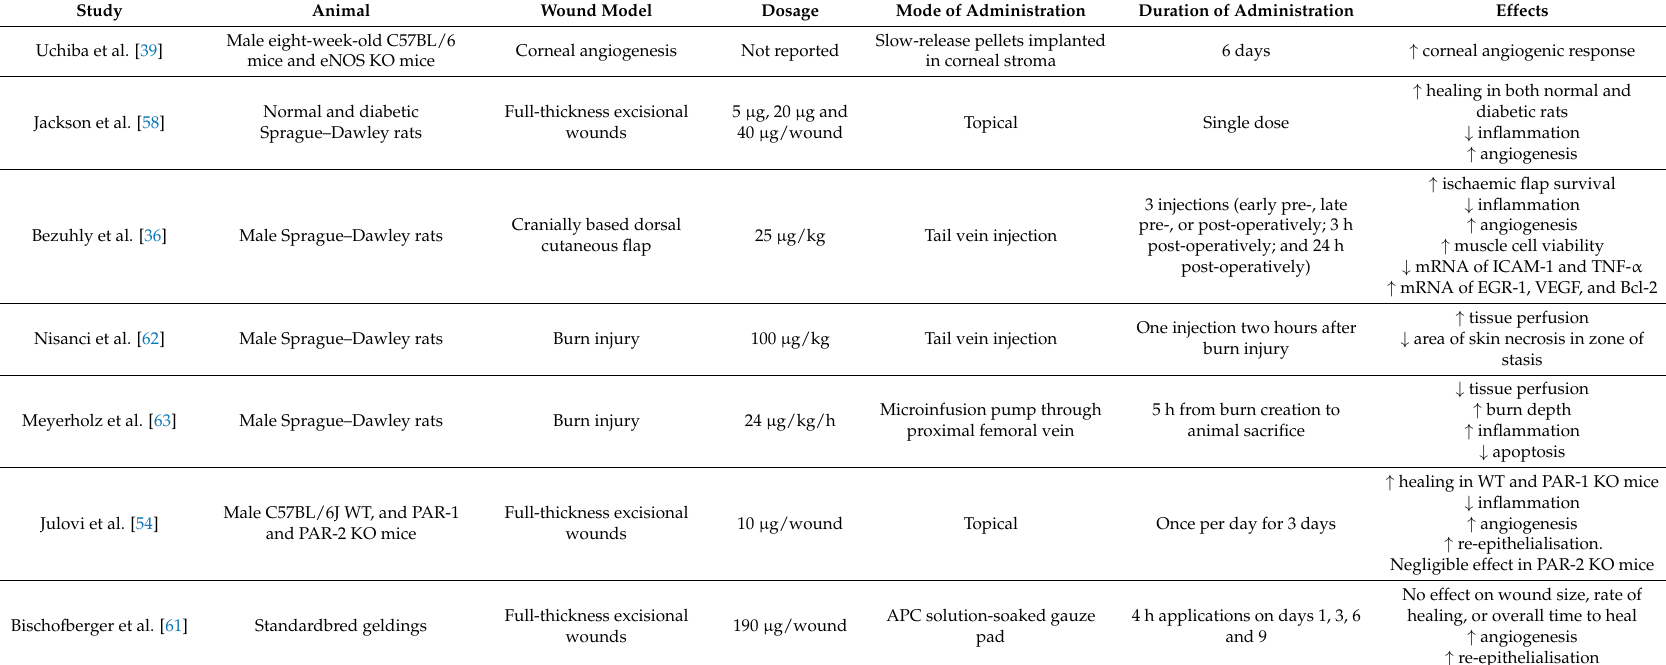
Table 1. APC in animal wound